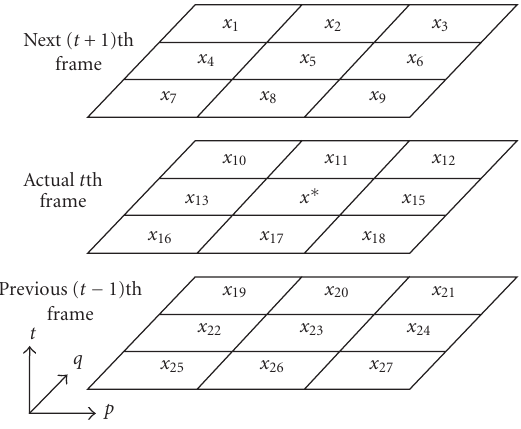
Figure 1: A 3 × 3 × 3 (cubic) spatiotemporal filtering window cen- tered in x ∗ = x ( N +1) / 2